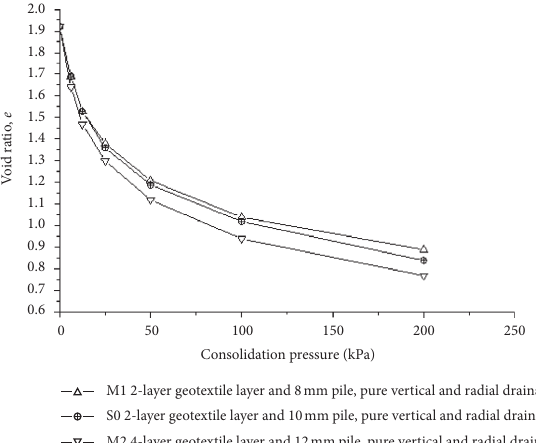
Figure 9: Curves of void ratio versus consolidation pressure for tests of Group B (M1, S0, M2).